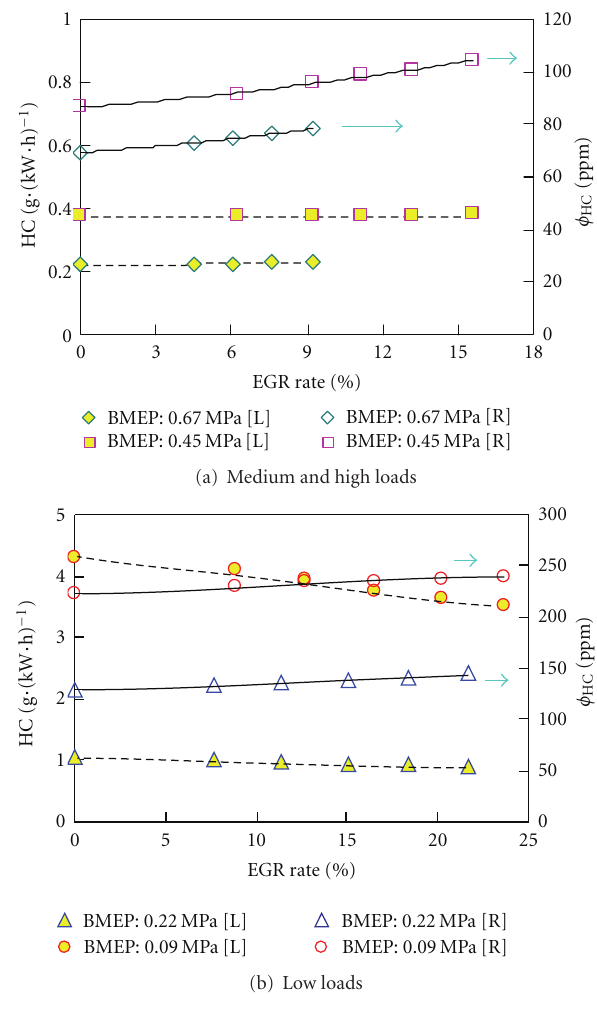
Figure 10: E ff ects of EGR rate on the HC emissions.